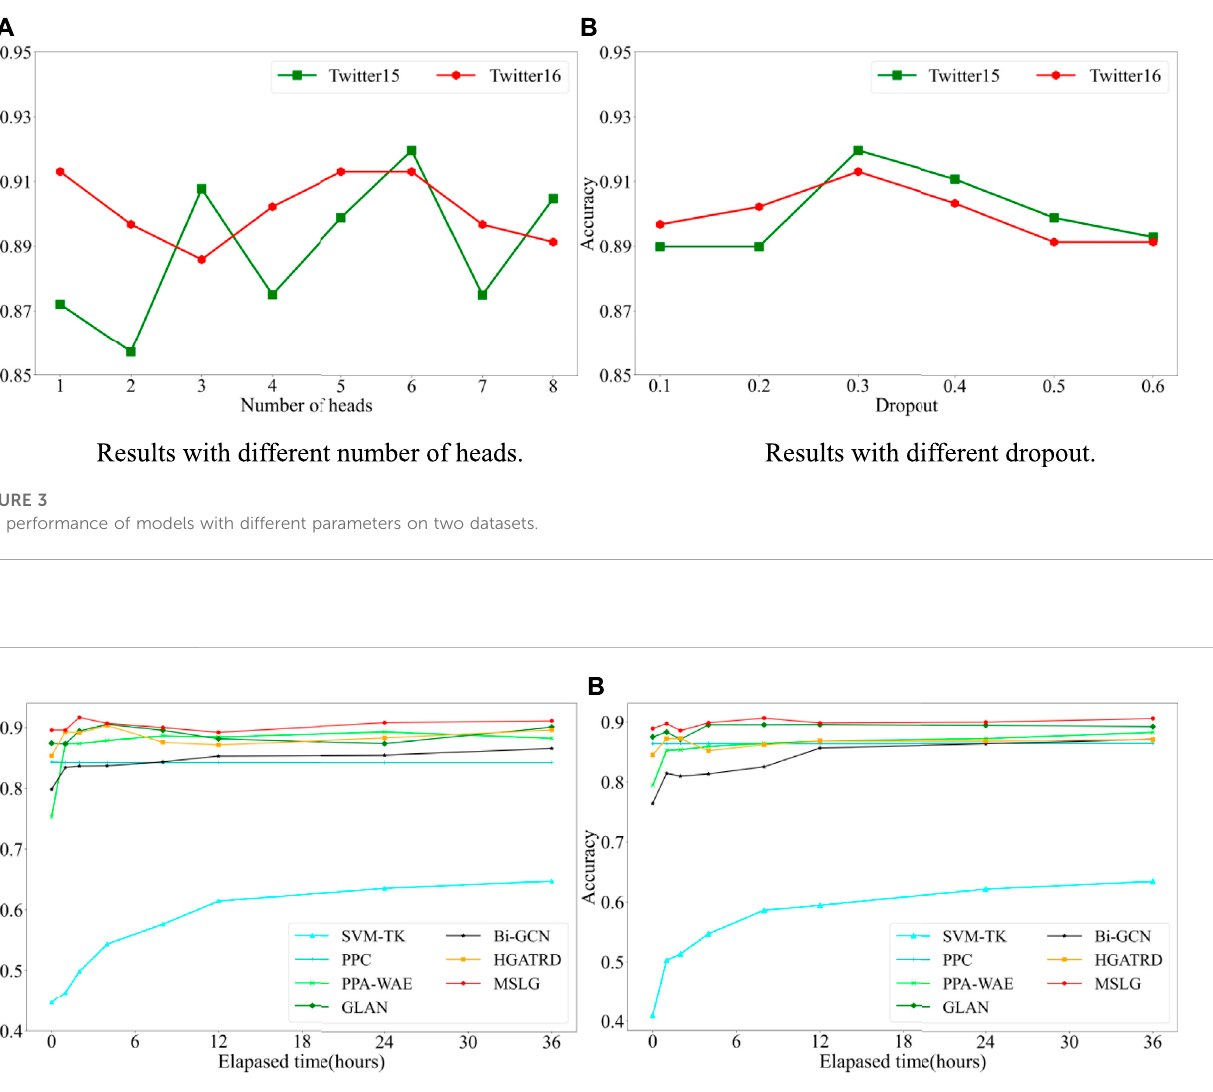
FIGURE 4 The performance of early rumor detection on two